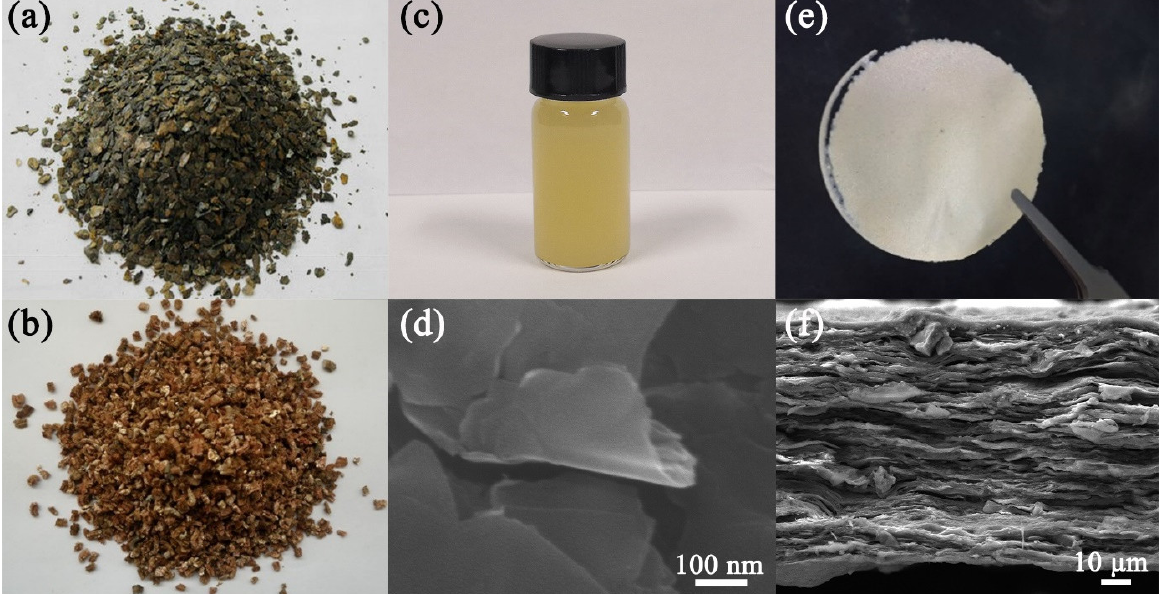
Figure 2. The morphology of vermiculite and film. The optical photos of raw vermiculite ( a ), thermal expanded vermiculite ( b ), IEVMT dispersion ( c ), and IEVMT film ( e ); the SEM images of dispersed IEVMT sheets ( d ) and the cross-section of IEVMT film ( f ).